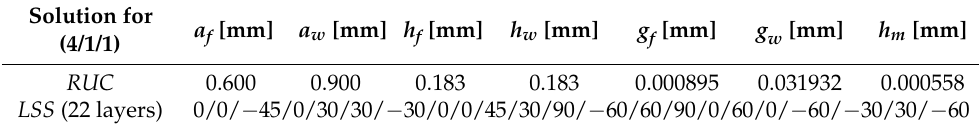
Table 6. The best solution found when using satin 4/1/1 fabric as reinforcement.